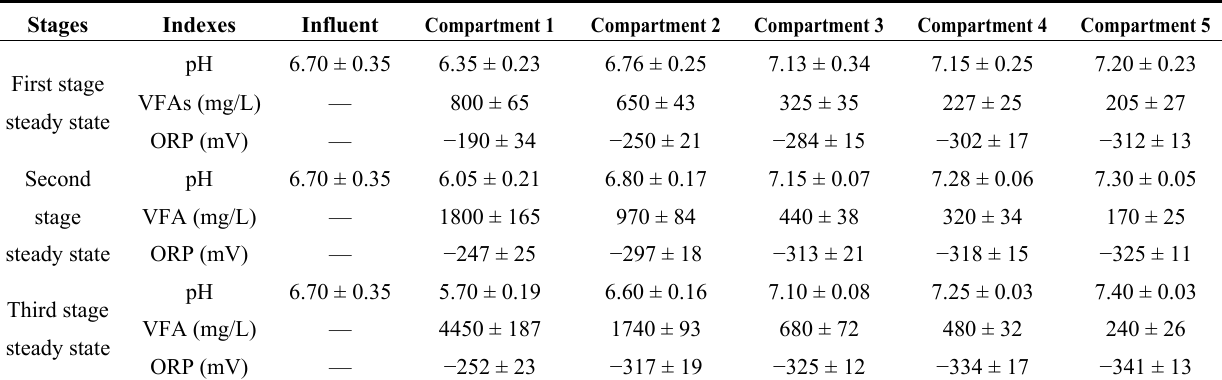
Table 1. Variation of pH, volatile fatty acids (VFAs), and oxidation-reduction potential (ORP) in the (anaerobic baffled reactor)